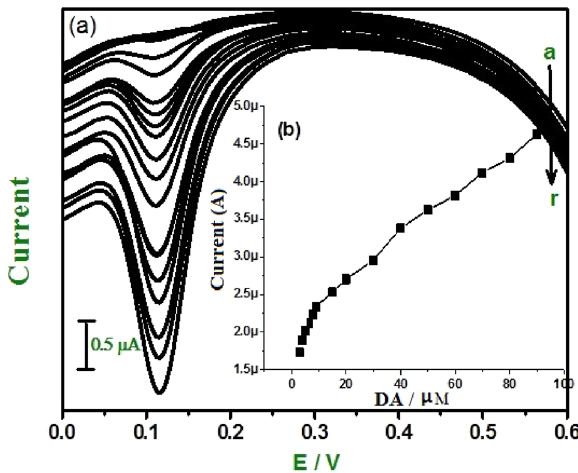
Figure 10. ( a ) Differential pulse voltammograms for different concentrations of DA (a-r) at E-GO modified CPE 0.2 M phosphate buffer solution. ( b ) Graph of anodic peak current vs. concentration of DA.